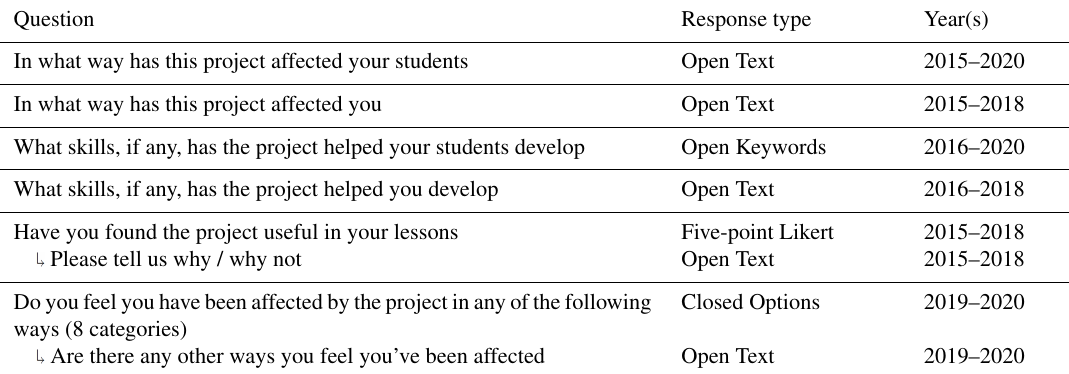
Table A2. Questions asked of